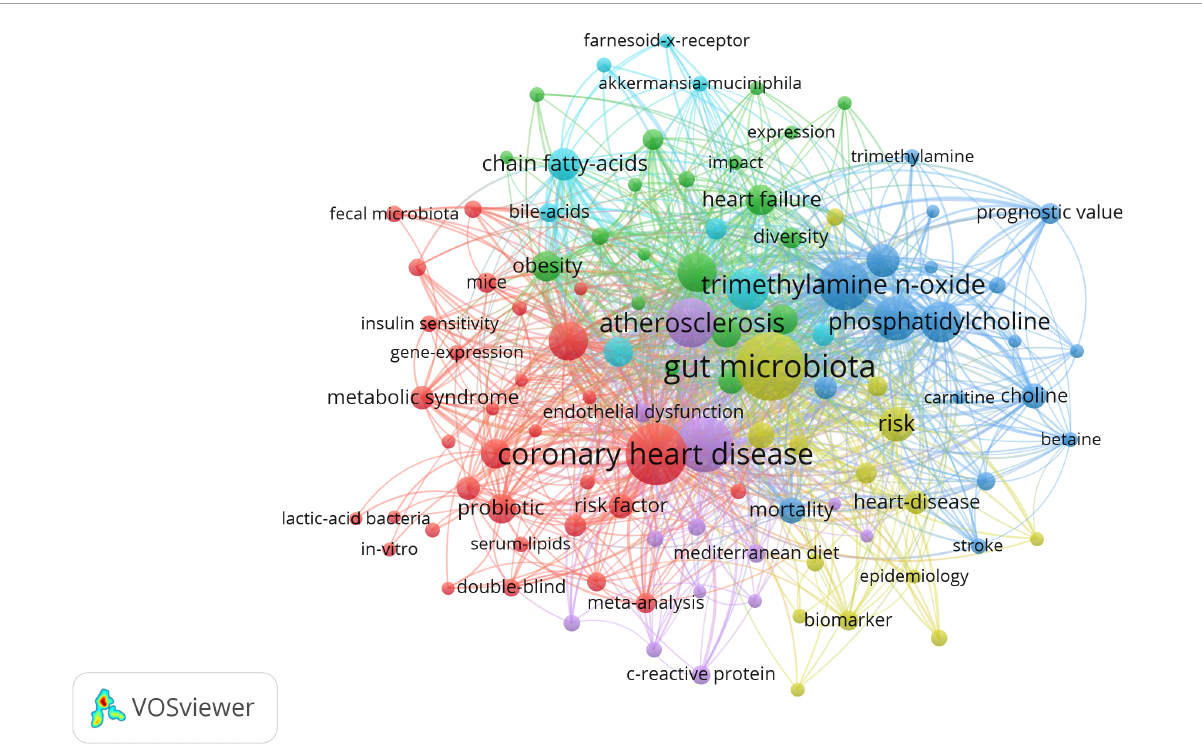
FIGURE6 The network visualization of keywords. The size of each circle represents the weight of a keyword. The distance between two circles indicates the relatedness between the two circles. The stronger the relatedness, the shorter the distance. The color of the circles represents the respective cluster